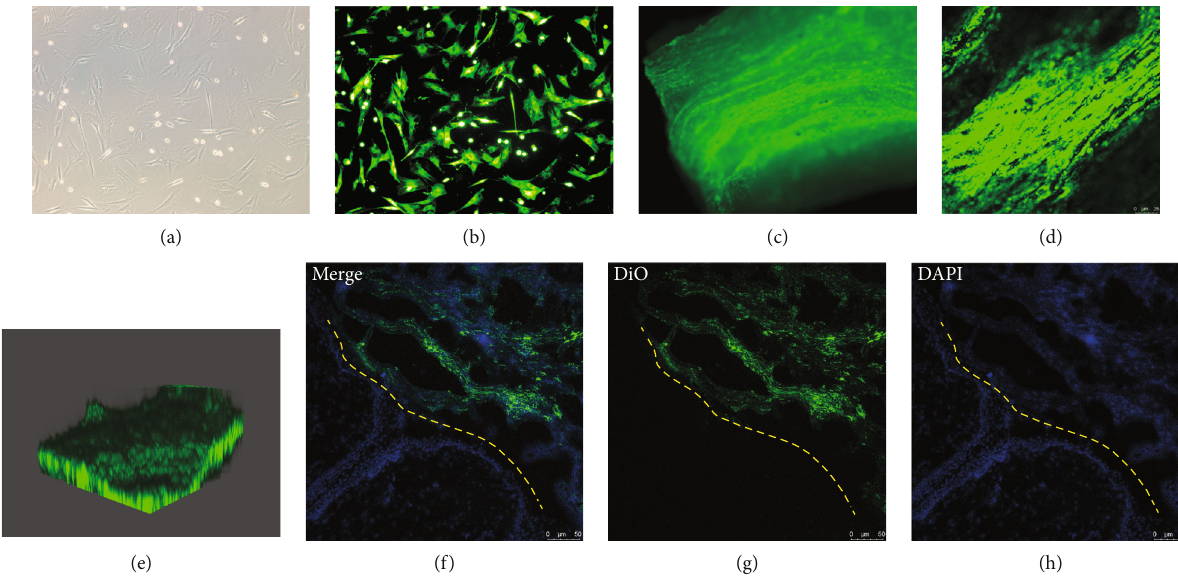
Figure 8: Cell tracing in vivo results. ADSCs were labeled with DiO (green) (a, b, 10x). Three days after RC with DiO-labeled ADSCs, microscopic images (c) and confocal images showed di ff use green fl uorescence throughout the recellularized sca ff old. By serial confocal imaging of the sca ff old, herein showed fl uorescent image of one random transverse section of the sca ff old (d) and confocal 3D images (e). Sca ff old with DiO-labeled ADSCs was implanted to the rat model, and microphotographs of cross-sections of the rat uterine cervix were taken 3 days after surgery. Merge (f), DAPI (h), and DiO (g) images of fl uorescence signals are shown, respectively. Nuclei of DiO- labeled transplanted donor cells and host cells were all stained blue with DAPI and distributed in all parts of the tissue, while green fl uorescence with DiO of donor cells only existed in the implant site. Yellow dashed lines represent the border between graft and adjacent original tissue. Scale bars represent 50 μ